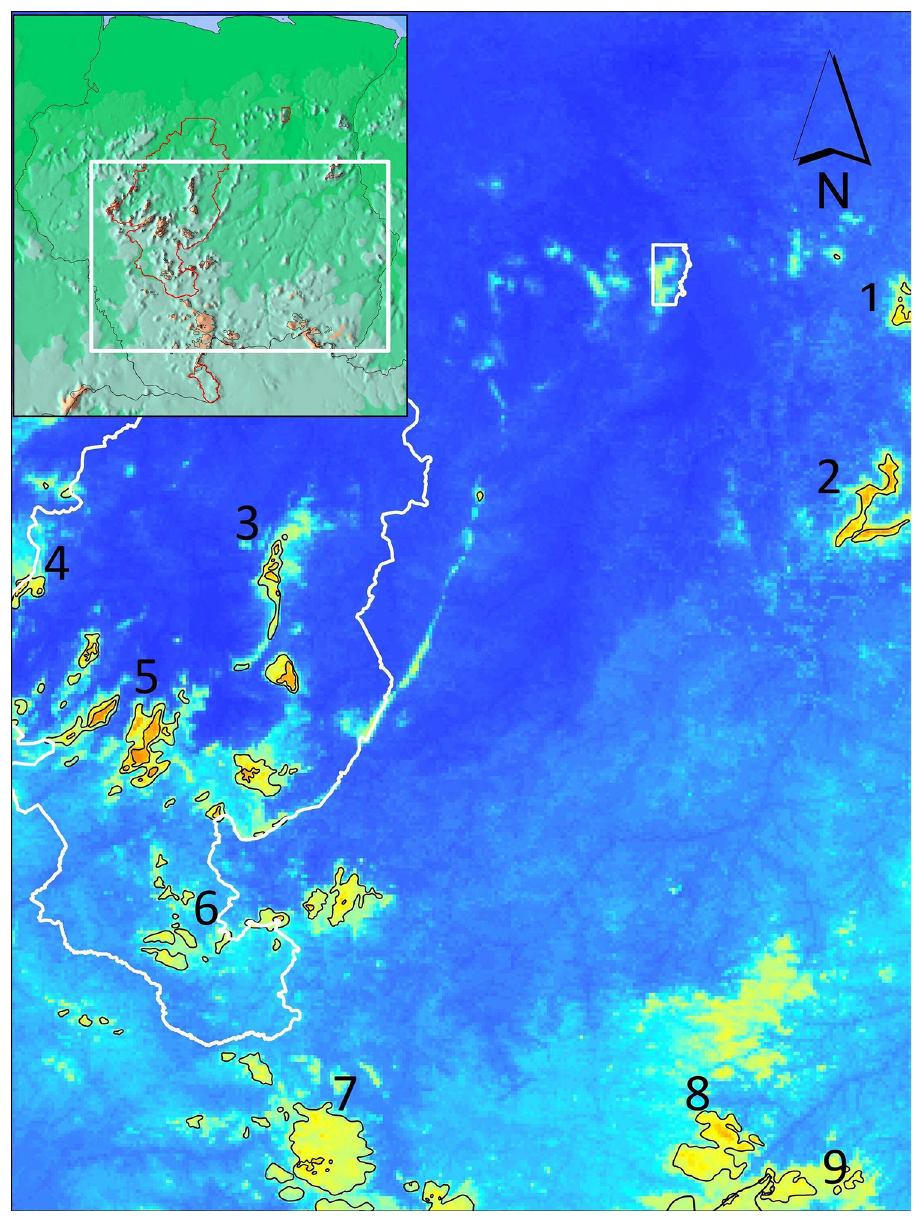
Fig 4. Overview of the areas in Suriname that are projected as viable for the fungus Batrachochytrium dendrobatidis . Warmer colors indicate higher chances of possible infection. Numericals are for areas listed as follow: (1) Nassau mountain, (2) Lely mountain, (3) Emma mountain range, (4) Bakhuis mountain, (5) Wilhelmina mountain range, (6) Eilerts de Haan mountain range, (7) Grens mountain range, (8) Oranje mountain and lastly (9) Tumuk Humak mountain